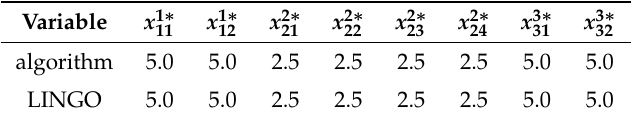
Table 2. The optimal bandwidth allocation for applications migration.